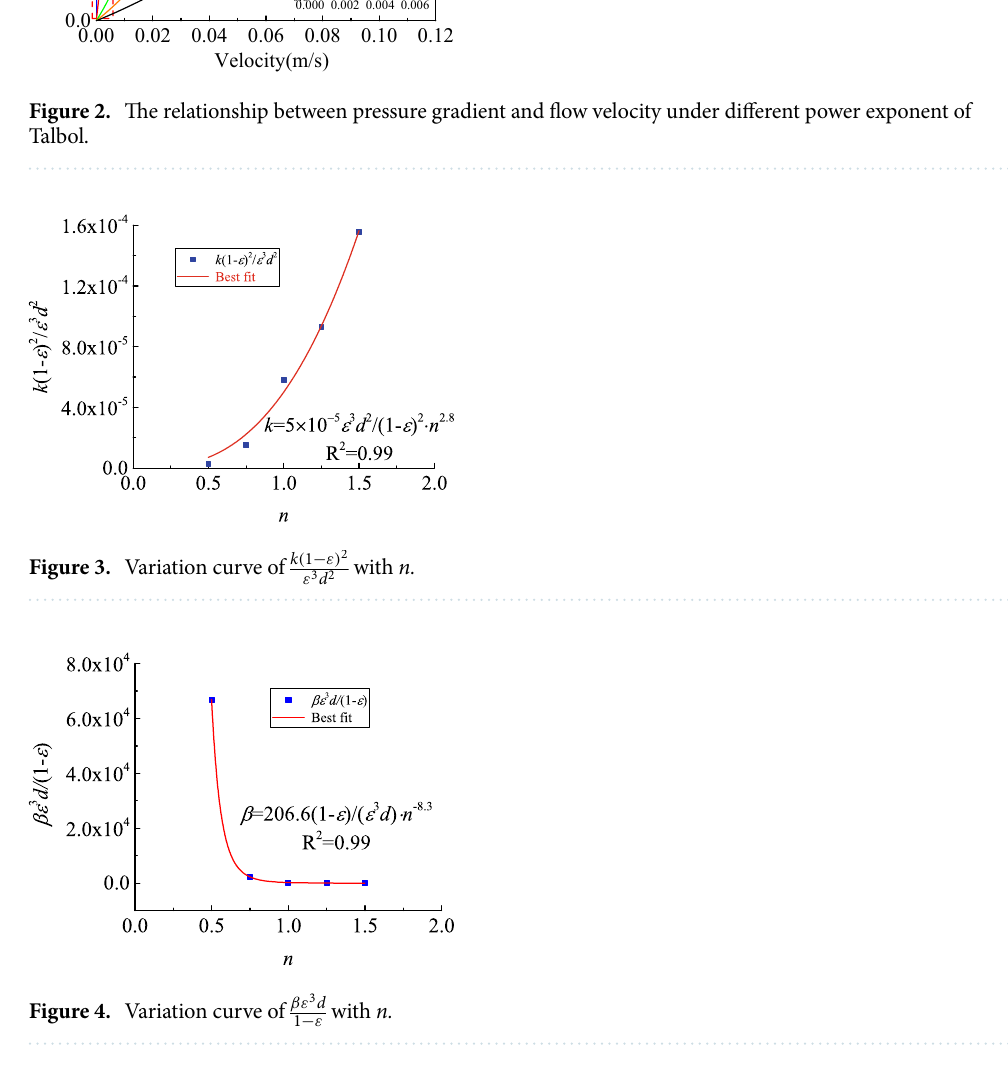
Figure 4. Variation curve of βε